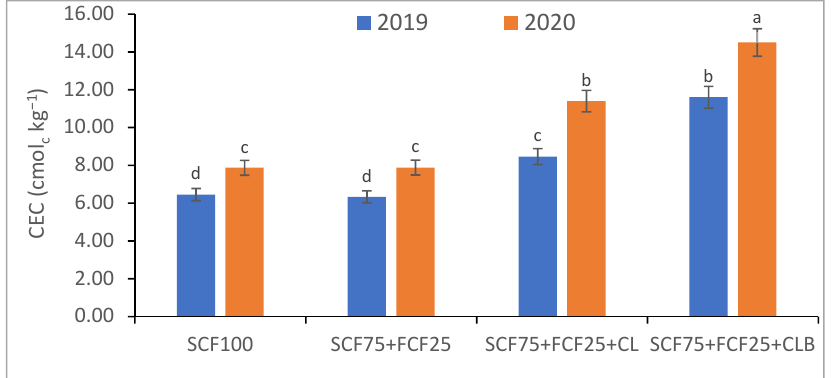
Figure 1. Response of cation exchange capacity to different fertilization strategies applied in two seasons (2019 and 2020) to sandy soil. Abbreviations of fertilization treatments are explained in Table 1. Bars with a different letter indicate significant difference between treatments at p ≤ 0.05.